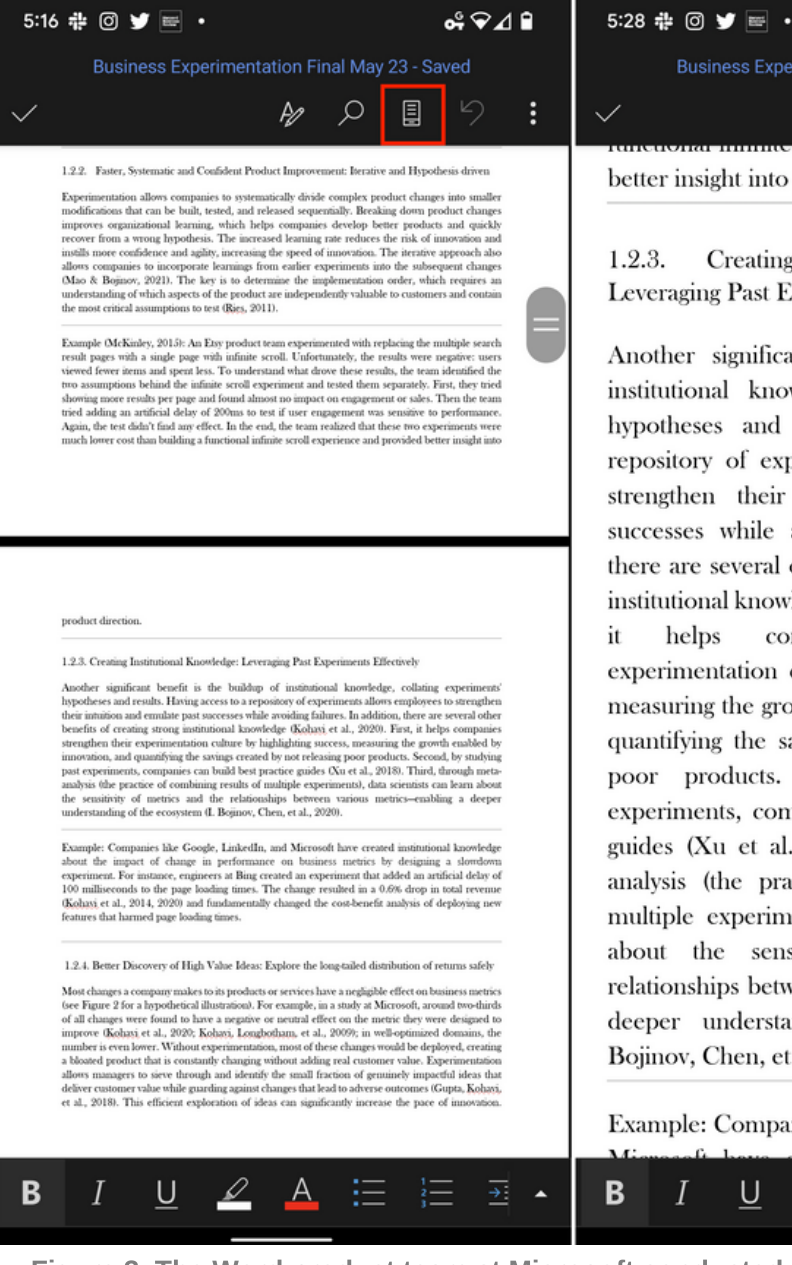
Figure 3. The Word product team at Microsoft conducted a controlled rollout on a feature that changed the default view of Word on Android devices from the “print layout view” (left) to the “mobile view” (right) (Xia et al., The change allocated more screen space to the document and zoomed in to make it easier to edit. However, the experiment had mixed results: the engagement metrics were only positive for users who had recently modified a document. This group was more active, but they only accounted for about 30% of the user base. In addition, there was a 13% increase in how often users switched to the non-default view within 5 s of opening the document. The feedback was incorporated into the feature redesign, resulting in a final product that displayed